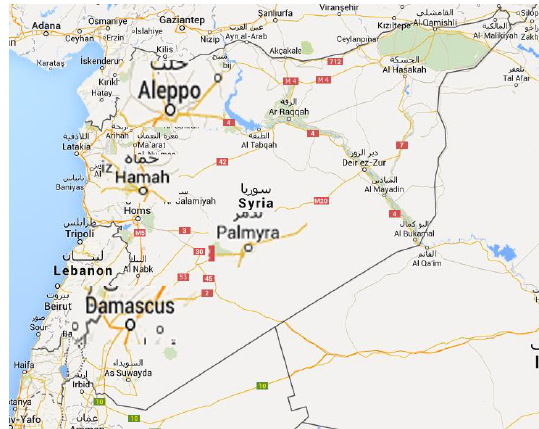
Figure 1. Syria Damascus, Shabba, Bosra, Hamah, Palmyra and Aleppo are the visited